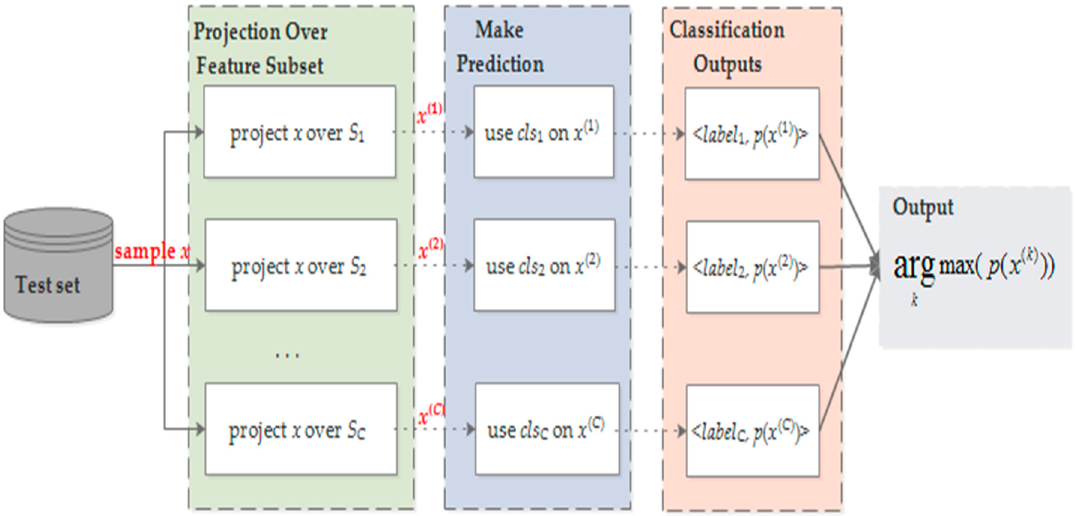
Figure 4. The scheme of classifying a test sample with the class dependent feature selection method.